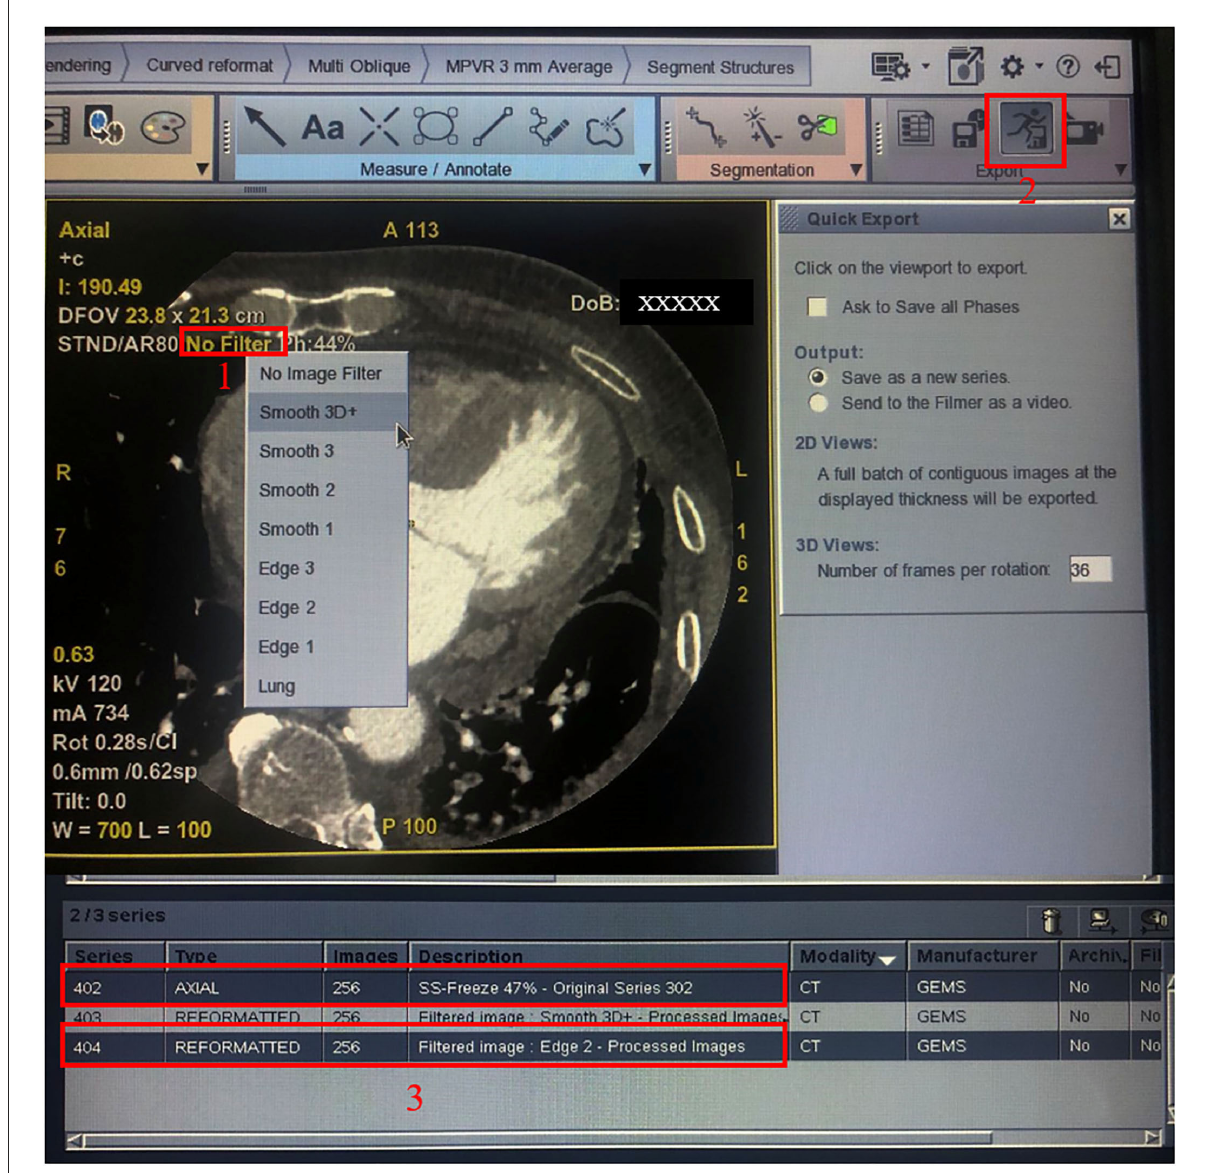
FIGURE2 Procedure for generating the SE group. Step 1: Click the “No Filter” option in red frame 1 and select smooth 3D + ; step 2: Click the button in red frame 2 to generate the smoothed 3D + group. Then, quit the software program and start again, repeat step 1 but choose the edge-2 filter, and repeat step 2 and generate the SE group. Finally, the original series 402 and the SE group 404 were showed in two red frame 3.